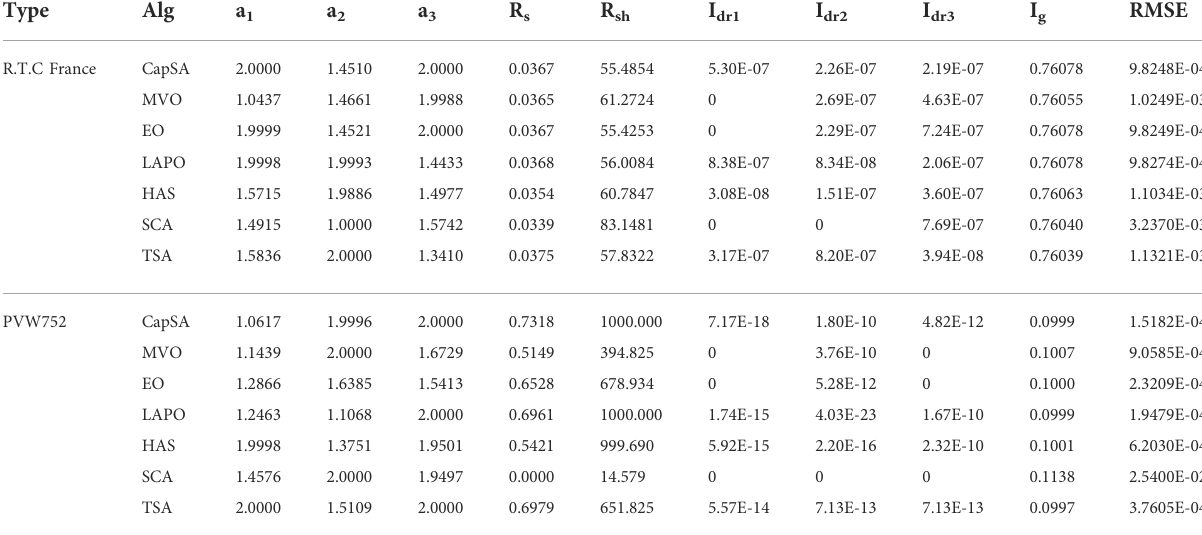
TABLE 4 TDM optimal parameters of R.T.C France and PVW752 PV